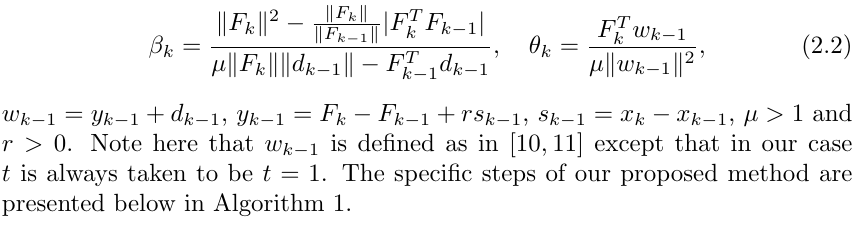
Algorithm 1 [Three-term Conjugate Gradient-based Method (TCGM)]